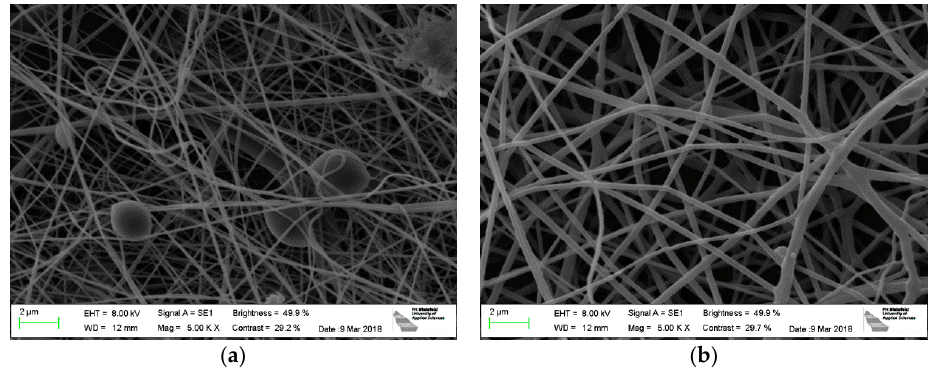
Figure 1. Electrospun PAN nanofiber mats: ( a ) PP as substrate; ( b ) aluminum foil as substrate.